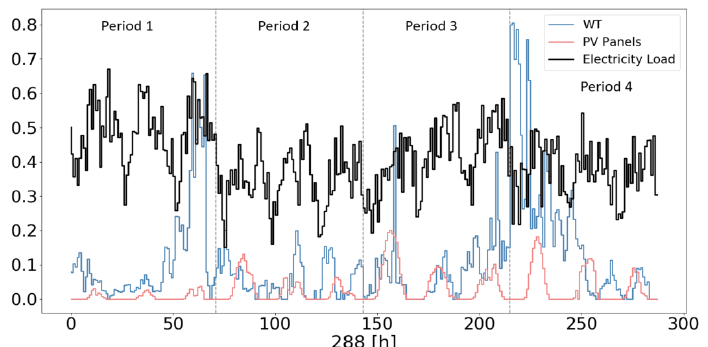
Figure 3. The four consecutive scenarios of 72 h. The vertical axis is the percentage of the total capacity that can be used by the WT/PV or the percentage of the energy demand for every hour.